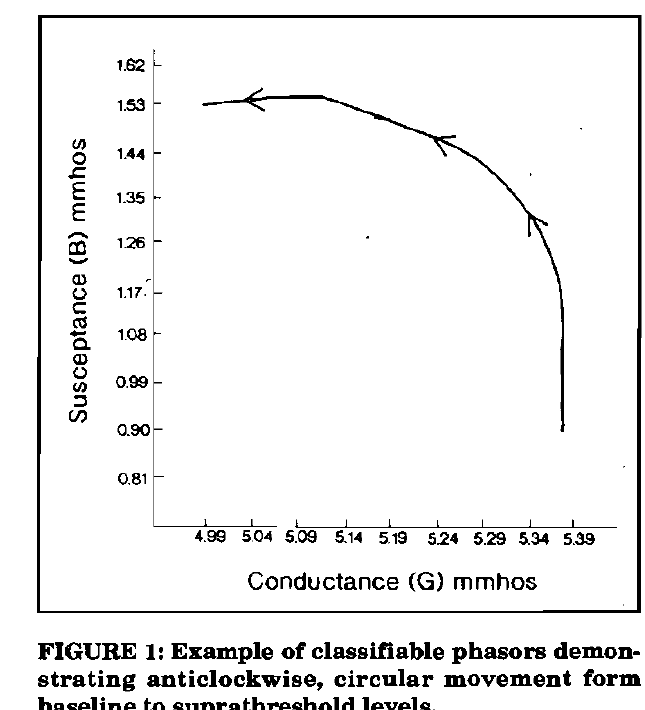
FIGURE 1: Example of classifiable phasors demon- strating anticlockwise, circular movement form baseline to suprathreshold